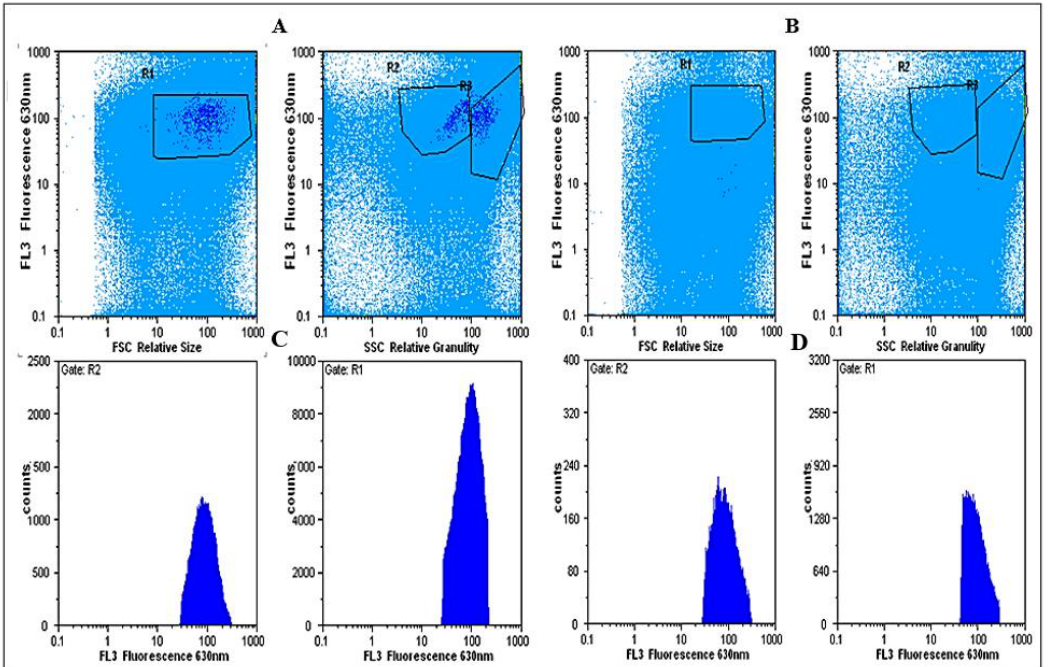
Figure 6. Cell viability. Peaks ( A , C ) control and ( B , D ) 500 µg L −1 SWCNT show the viable T. suecica cells using flow cytometry (Cyflow). ( A , B ) R1 is the defined cell population from which other graphs are extrapolated, and R1 represents the cell population as a histograms. ( C , D ) Shows the ratio of live and dead cells. Live cells appear as one large fluorescence peak, whereas dead or necrotic cells are represented as one small fluorescence peak. Statistically, there was a significant decrease in cell viability of algal cells when exposed to 500 µg L −1 SWCNT (One Way ANOVA: F = 1.91, df num = 1, means ± SD; n = 3; p < 0.001).